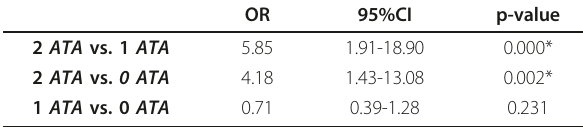
Table 3 ATA frequencies in the female subgroup FEMALES Table 4 ORs of ATA as risk factor for schizophrenia